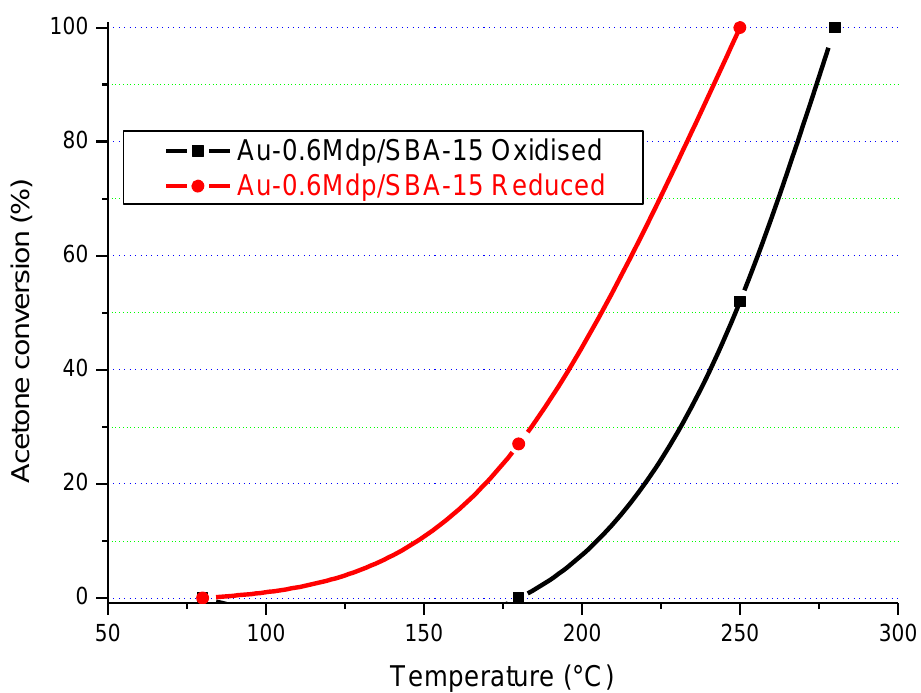
Figure 17. Complete oxidation of acetone over oxidised and reduced Au-0.6M dp/SBA-15 samples.